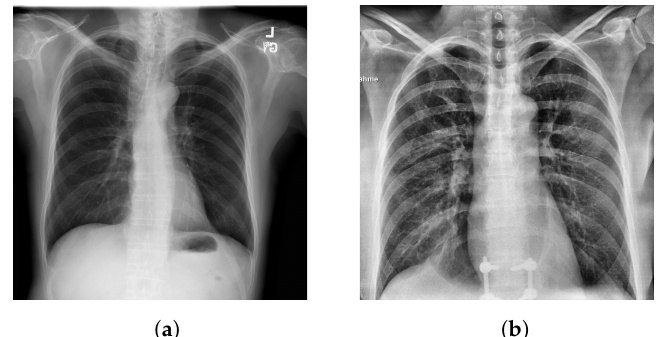
Figure 1. X-rays of healthy and infected patients. X-rays from [7,8]. ( a ) Sample X-ray for healthy lungs ( b ) Sample X-ray for COVID-19-infected